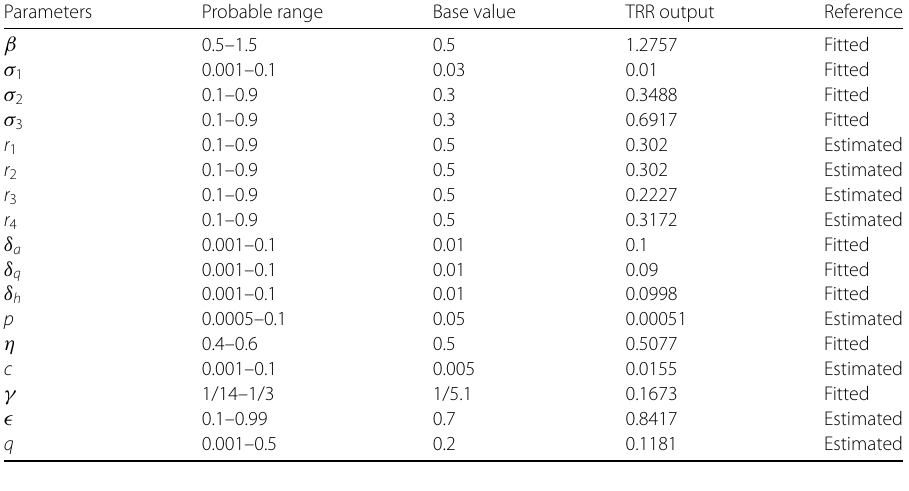
Table 2 Model parameters calibration by using the mentioned scheme Parameters